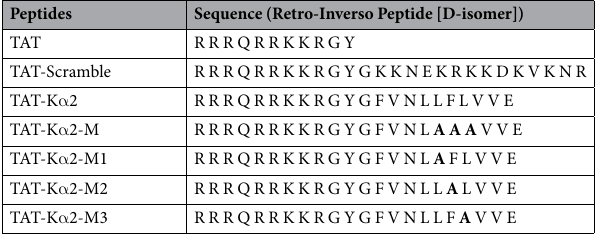
4 Scientific RepoRts | 7: 4875 | DOI:10.1038/s41598-017-04777-4